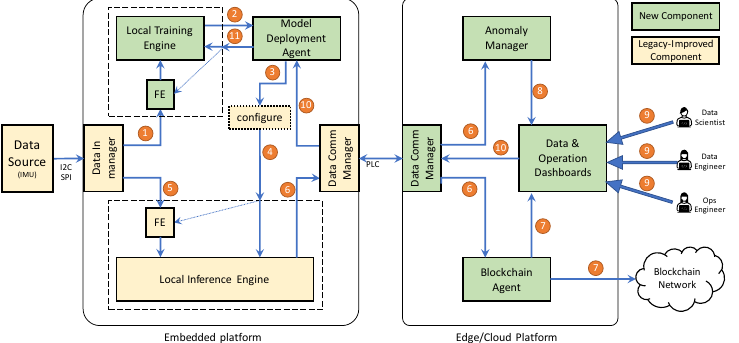
Figure 2. Schema of the proposed system including the Tiny-MLOps pipeline. Green blocks are the newly introduced blocks, while yellow blocks have been improved since [13].